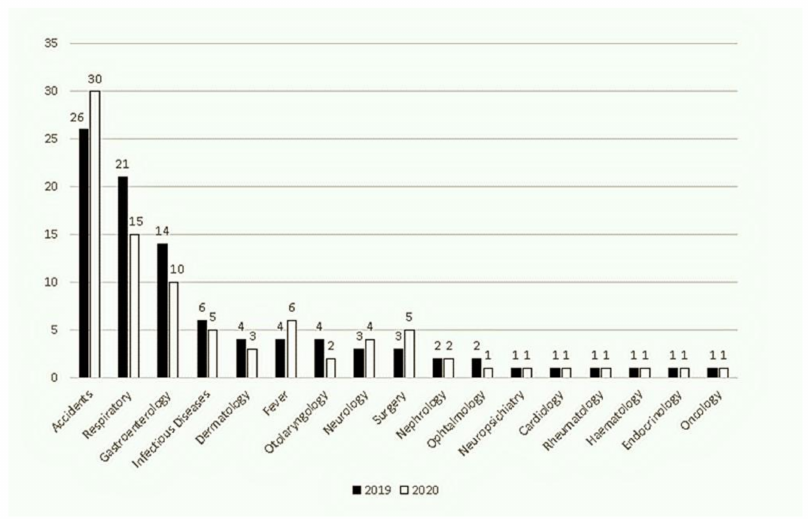
Figure 3. Proportion of pediatric ER diagnoses in September–November, 2019 and 2020. The decrease in air communicable diseases (13,134 vs. 4754: − 63.8%) was significantly higher compared to non-air communicable diseases (19,434 vs. 11,334: − 41.7%) ( p < 0.001). Analyzing respiratory diseases alone, we found a statistical significantly decrease in respi- ratory diseases (6743 vs. 2393, − 4%) compared to the total amount of the others 16 specific diagnoses evaluated in this study (25,296 vs. 11,667, +4%) ( p < 0.001). ER visits in each triage category decreased in 2020. Our data showed 118 vs. 43 red codes, 3083 vs. 1954 yellow codes, 25,369 vs. 11,898 green codes, and 3998 vs. 2189 white codes in 2019 vs. 2020, respectively. By contrast, considering the proportion of each category over the total number of visits per reference period, the red codes remained almost similar (0.4% vs. 0.3%, p = 0.85), while the yellow codes increased (9.4% vs. 12.2%, p < 0.001), green codes decreased (77.9% vs. 73.9%, p < 0.001), and white codes slightly